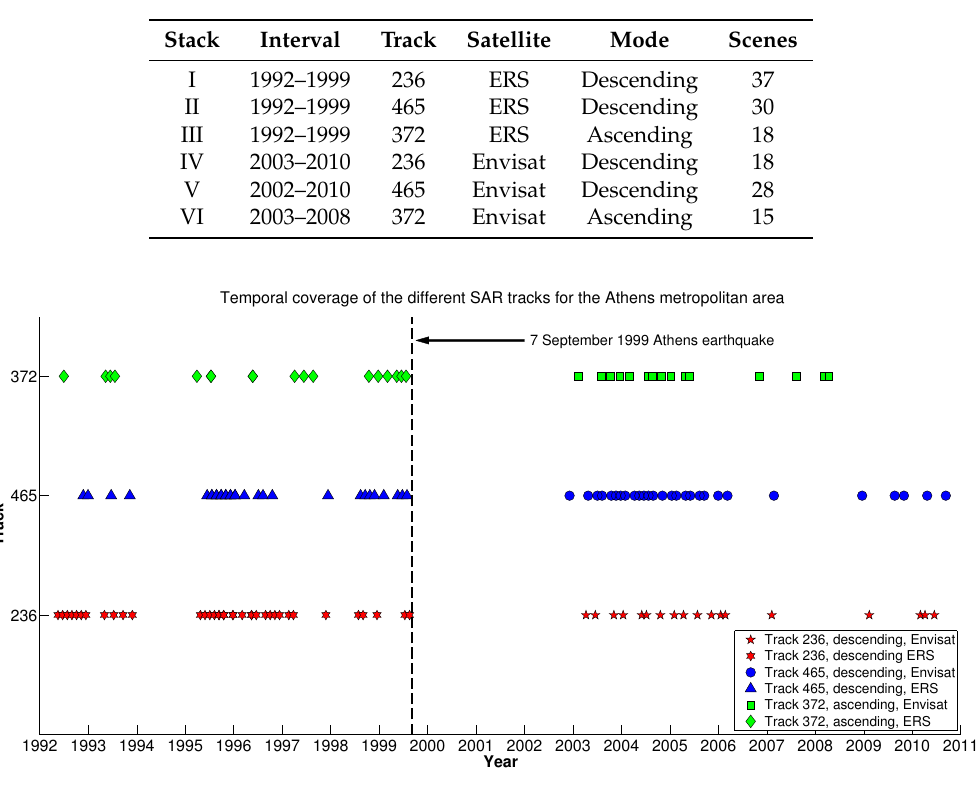
Figure 3. Temporal coverage of the six interferometric stacks. The vertical dashed line corresponds to the timing of the 1999 Athens earthquake. Two adjacent descending tracks and one ascending track were used for the 1992–1999 and 2002–2010 periods that were